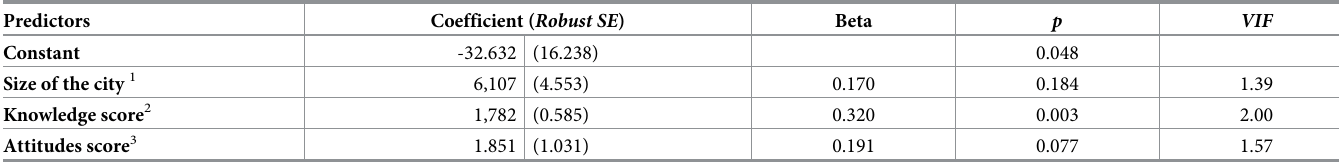
Table 6. Multiple linear regression to predict the proportion of PrEP advice provided proactively to MSM and trans persons who meet the criteria be offered PrEP according to the German and Austrian guideline (at-risk patients).